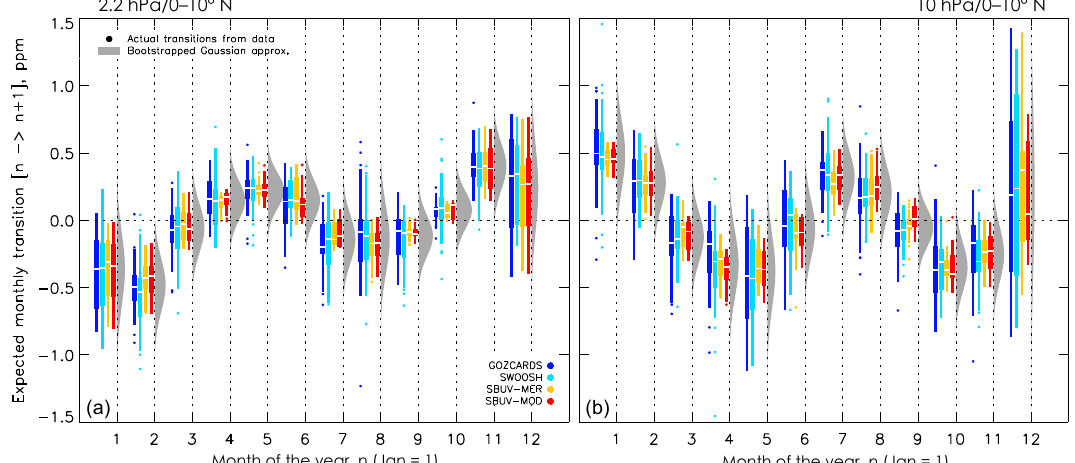
Figure 5. The expected monthly ozone changes (or “transitions”) between month n and the next month, n + 1, i.e. index 1 represents a change between January and February. We show two examples at 0–10 ◦ N: (a) 2.2 and (b) 10hPa. The box-and-whisker plots are for all observations when no change in the underlying instrument of the composites occurred and represent the interquartile range (IQR) covering the 25th to 75th percentiles (box) and 1.5 times the IQR or the maximum, whichever is smallest (whisker); outliers are plotted as dots. Plotted to the left of the vertical lines at each index are the changes between months for each composite (represented by the different colours); Gaussian distributions to the right of the vertical lines represent those formed from the mean and standard deviation of all the composite transitions from 1000 bootstraps. These Gaussians are used as transition prior estimates and are calculated for all pressures and